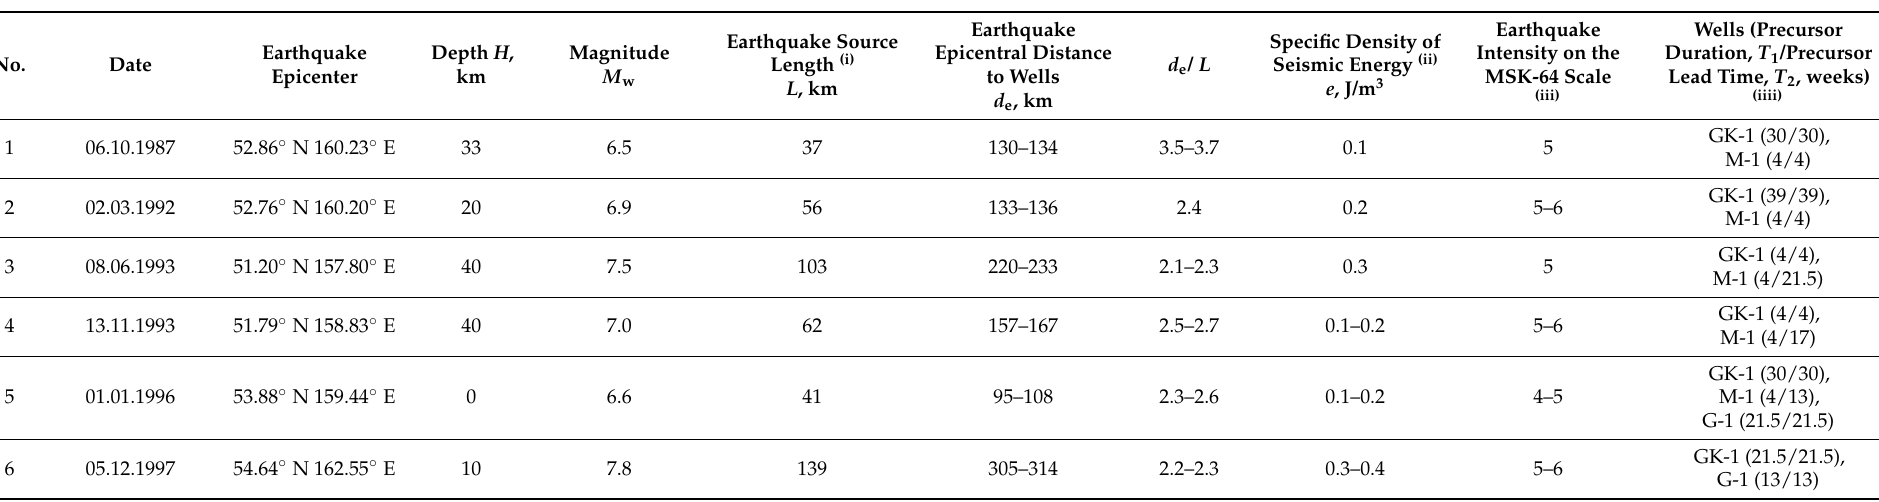
Table 2. Earthquakes (https://earthquake.usgs.gov/earthquakes/ (accessed on 2 July 2021), http://sdis.emsd.ru/info/earthquakes/catalogue.php (accessed on 2 July 2021)) preceded by hydrogeochemical precursors in at least two flowing wells, Kamchatka